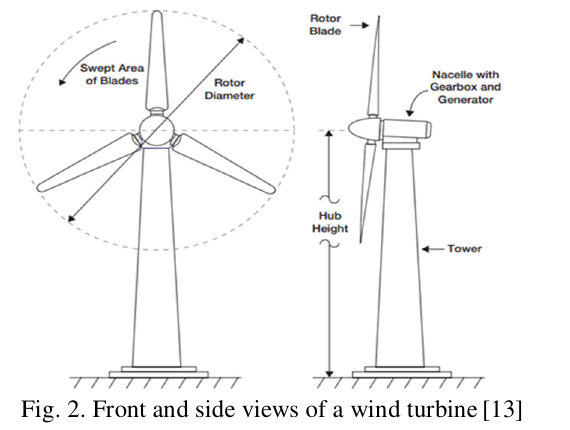
Fig. 2. Front and side views of a wind turbine [13]